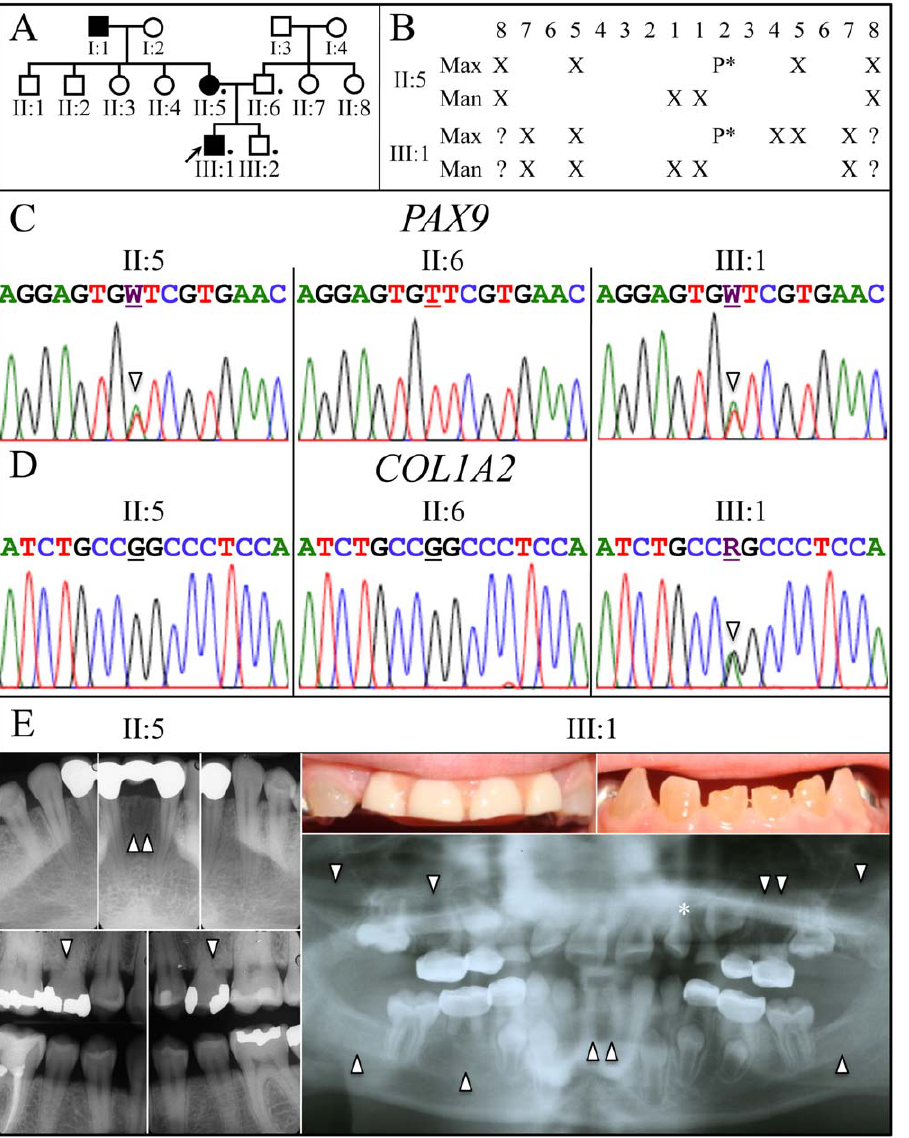
Figure 1. Family pedigree, missing teeth and disease causing mutations. A: The family pedigree follows the tooth agenesis trait for 3 generations and is consistent with an autosomal-dominant pattern of inheritance. Key : A filled icon indicates tooth agenesis. A dot indicates individual who donated samples. B: Chart of missing teeth in mother (II:5) and the proband (III:1). C: DNA sequencing chromatograms show that the affected mother (II:5) and proband (III:1) had a T or A (W) (arrowhead) at position g.5368 (NCBI Ref. Seq. NC_000014.8). This PAX9 mutation (g.5368T . A; c.43T . A; p.Phe15Ile) caused the tooth agenesis. D: DNA sequencing chromatograms show both parents (II:5; II:6) had the wild-type G, while the proband had a G or A (R) (arrowhead) at position g.15941 (NCBI Ref. Seq. NG_007405.1). This spontaneous COL1A2 mutation (g.15941G . A; c.1171G . A; p.Gly391Ser) caused the dentin defects in the proband. E: Radiographs of the mother (II:5) and proband (III:1) document the missing teeth (arrowheads) and the peg lateral (*) in the proband. Oral photos show the proband’s primary anterior teeth show the brownish discoloration and attrition. His maxillary incisors were removed because of severe attrition and a pediatric partial denture was placed. The proband’s radiographs show the bulbous crowns with cervical constrictions and thin, narrow roots.